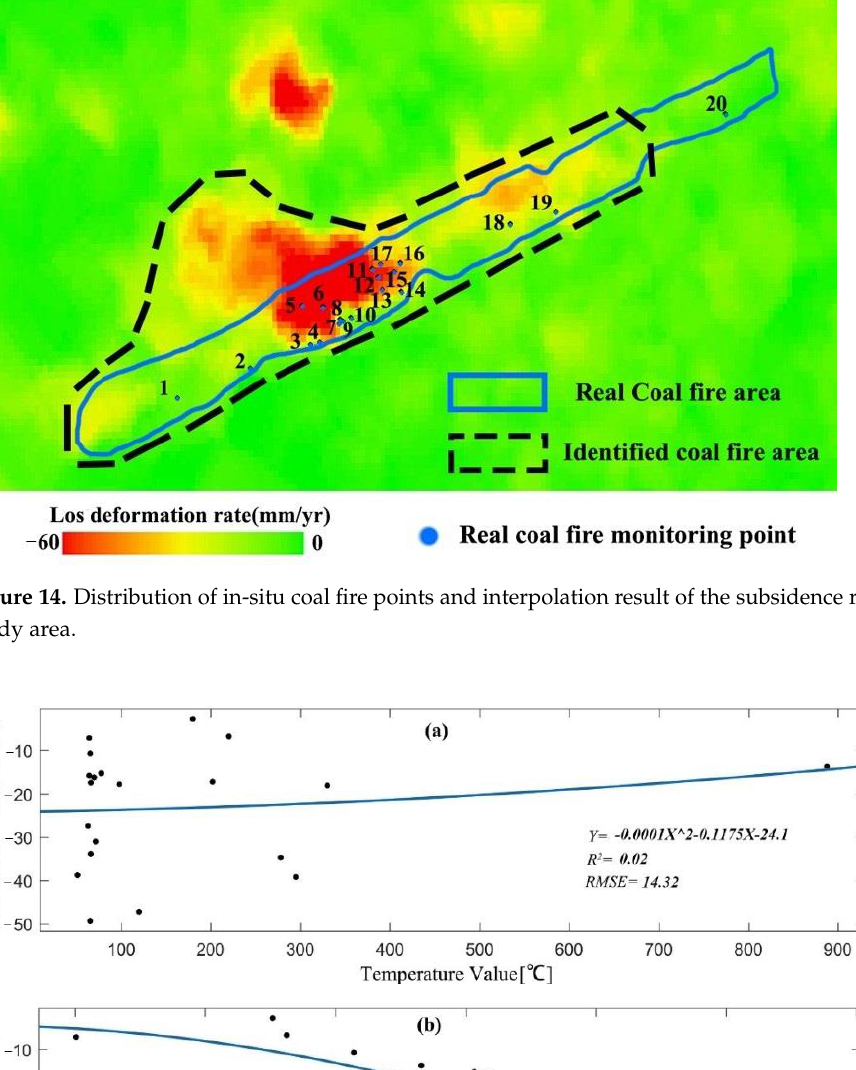
Figure 14. Distribution of in-situ coal fire points and interpolation result of the subsidence rate in the study area.